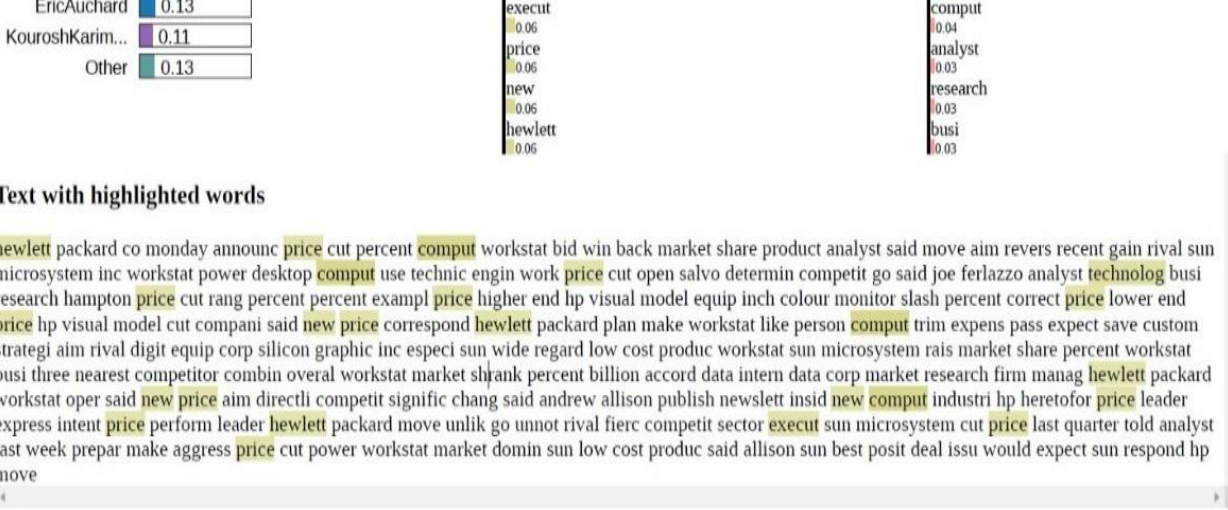
Figure 8. Explanation of individual prediction of the proposed method on the IMDB62 document using LIME. It was observed for the Twitter50 dataset in Figure 9 that the RDNN method as- signed the same prediction probability of 32% to the authors “ JacaNews ” and “ Max- Boot ” . In addition, the method put the same weight on the function words “ american ” and “ britain ” , which represent two different classes of authors, not JacaNews and Jac- aNews. The correct decision of the method shows that features such as ” america ” and “ wit ” are from JaceNews as an author, and words such as “ britain ” are more significant to MaxBoot as the author with a probability value.